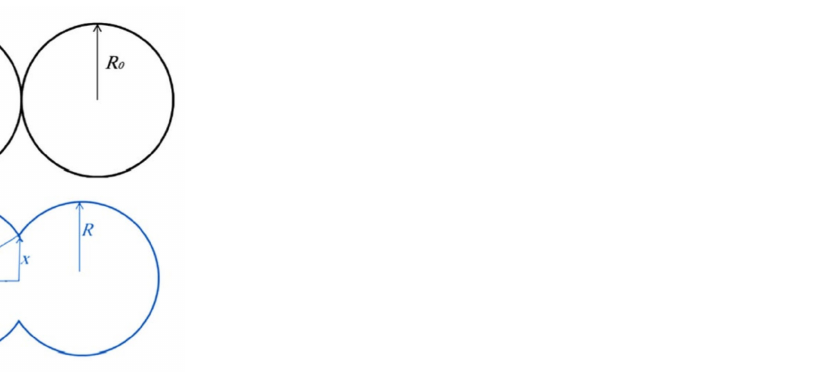
Figure 4. Coalescence of two particles at the moment of contact and after bridge formation (neck-